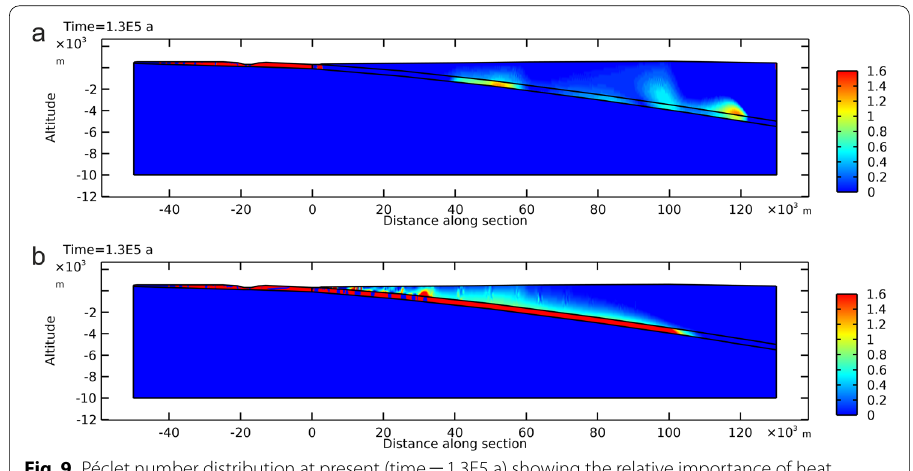
Fig. 9 Péclet number distribution at present (time 1.3E5 a) showing the relative importance of heat = advection versus conduction with a constant surface temperature in a the low Malm permeability scenario (i.e. model run A introduced in Fig. 3), and b the high Malm permeability scenario (i.e. model run B). The geothermal Péclet number is dimensionless. Vertical exaggeration equals